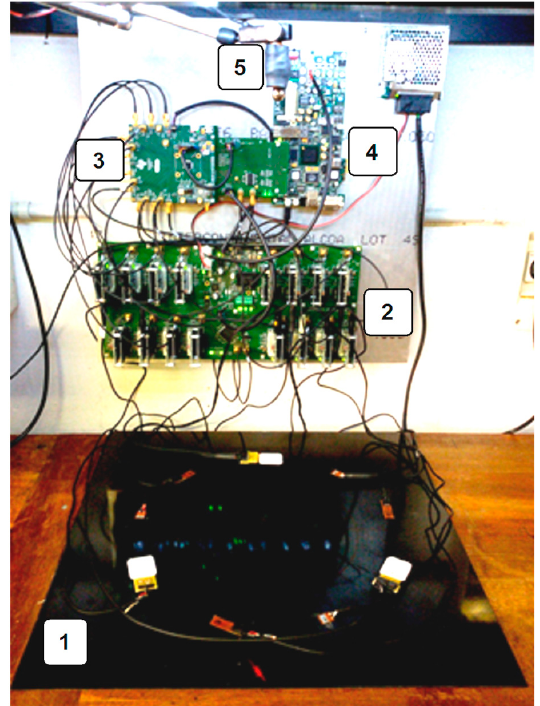
Figure 2. Picture of the experimental test bench: ( 1 ) CFRP test plate with all the sensors attached; ( 2 ) custom signal conditioning electronics; ( 3 ) multichannel variable gain amplifier (VGA) with ADC evaluation module (Texas Instruments AFE5851EVM); ( 4 ) Spartan-6 FPGA evaluation card (Xilinx SP605); ( 5 ) electromagnet retaining the impactor sphere.